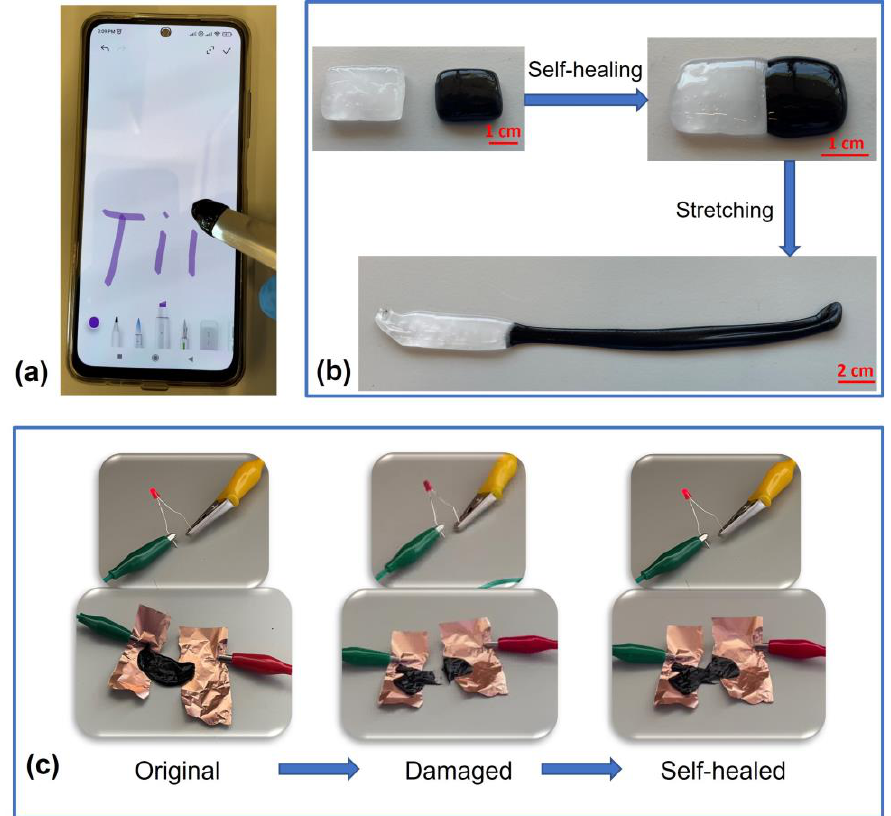
Figure 6. Illustration of the applications and the self-healing capability of conductive hydrogels: ( a ) touch screen property, ( b ) self-healing by rejoining without any external stimuli, and ( c ) the regaining of the conductive properties after the self-healing process.